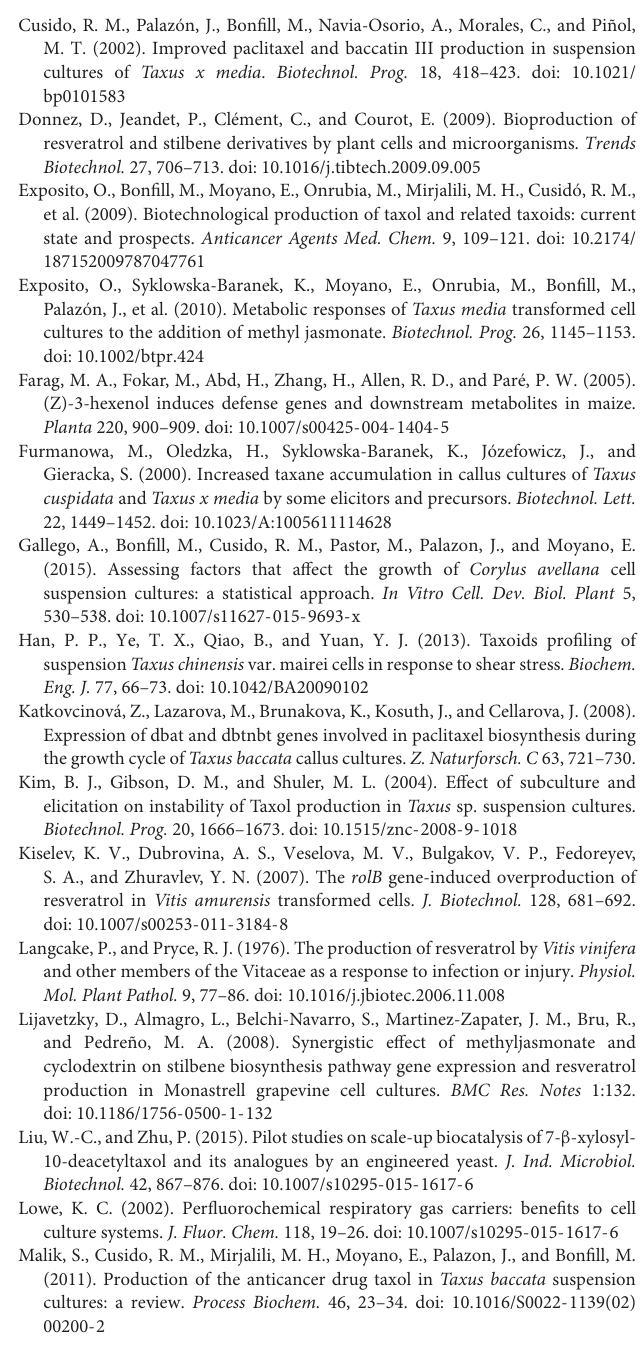
FIGURE S1 | Seven day old T. media and V. vinifera cell cultures. TABLE S1 | Sequences of the primers used to amplify genes by quantitative real-time PCR in T. media and V. vinifera cell cultures. TABLE S2 | Individual taxanes, expressed as a percentage of the total produced in T. media cell cultures grown for 24 days. Control; PDFgas, gassed perfluorodecalins; PFDdegas, degassed perfluorodecalins; PDFgas + CC, gassed perfluorodecalins plus Coro and β -CDs; PDFdegas + CC, degassed perfluorodecalins and Coro + β -CDs; Hex, Hexenol; Hex + CC, Hexenol and Coro + β -CDs. Data are the mean of three independent replicates ±